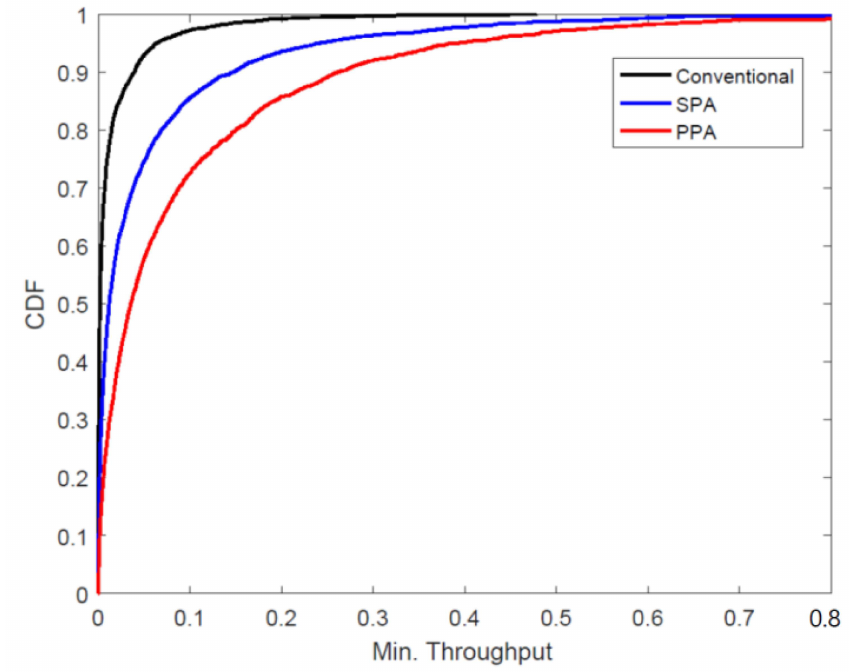
Figure 12. CDF of the minimum uplink rate per user when M = 64 using an MRC